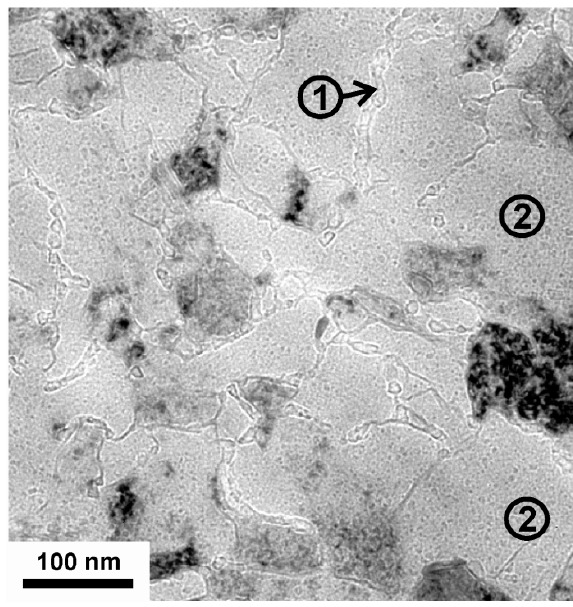
Figure 4. Over-focused plan view TEM micrograph of c-Ti 1050 °C taken at a lower magnification than in Figure 3. The grain boundary phase is indexed with (1) and the formation of nm-size precipitates within the grains are indexed with